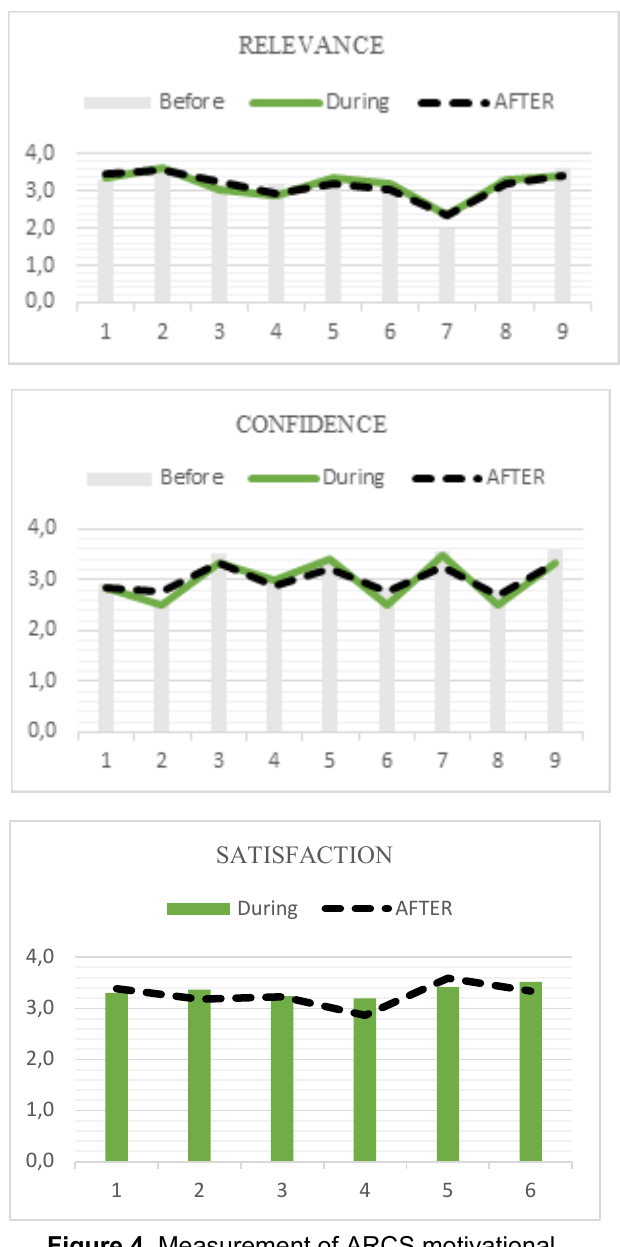
Figure 4. Measurement of ARCS motivational factors - before, during and after the